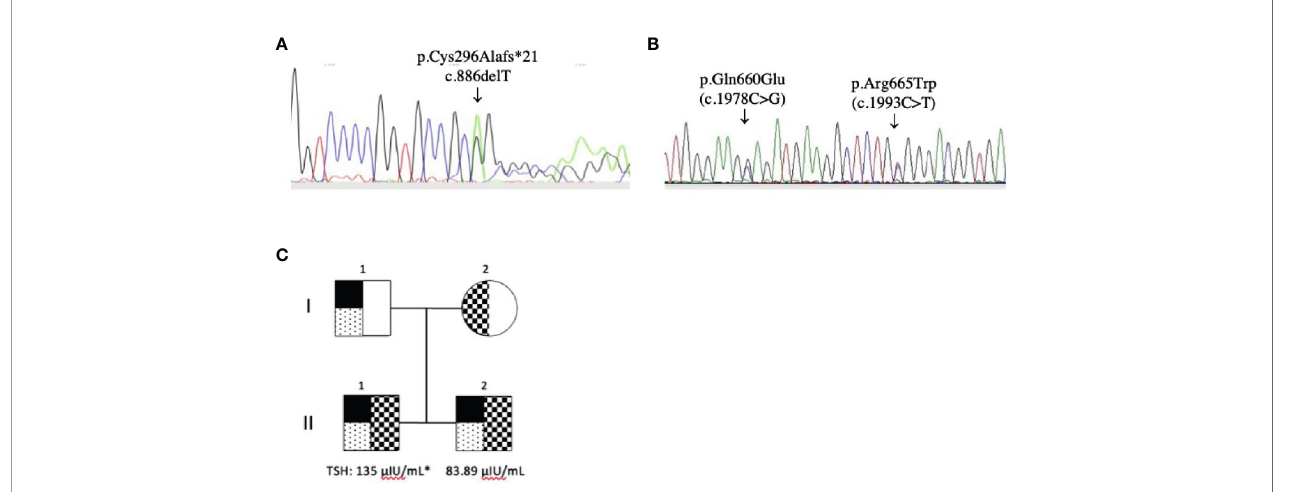
FIGURE 1 | TPO gene mutations. (A) p.Cys296Alafs*21 (c.886delT) in exon 8 (reverse sequence) and (B) p.Gln660Glu (C.1978C>G) in exon 11 and p.Arg665Trp (c.1993C>T) in exon 11 (reverse sequence); (C) Pedigrees of the family and THS values at diagnosis (* cordocentesis). The p.Cys296Alafs*21 (c.886delT) and the p.Gln660Glu (C.1978C>G) mutation was detected in both patients (II.1 and II.2) and the father (I.1). The p.Arg665Trp (c.1993C>T) mutation was detected in both patients and the mother (I.2).